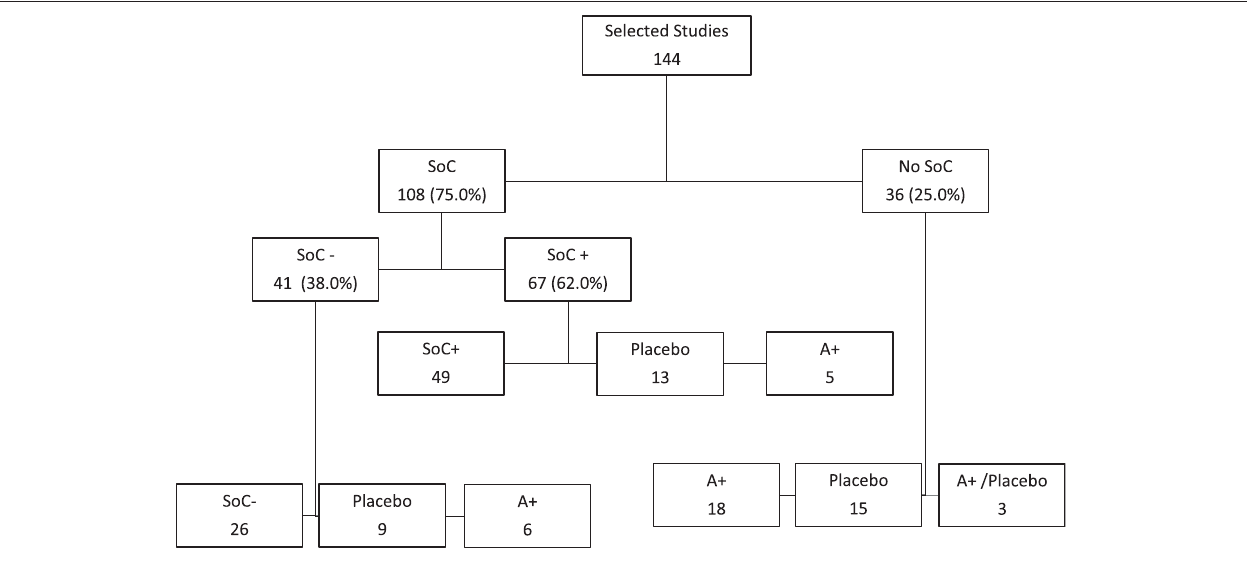
FIGURE2| InclusionorexclusionofStandardofCare(SoC)intheselectedstudiesascomparators.1. SoC + (cid:1) StudieswithStandardofCareincludingtreatments under investigation for COVID-19; SoC − (cid:1) Studies with Standard of Care without speci fi cations regarding the potential therapies allowed in the control groups; Placebo (cid:1) Studies with Placebo in the control group; A + (cid:1) Studies including in the control group one or more active control.